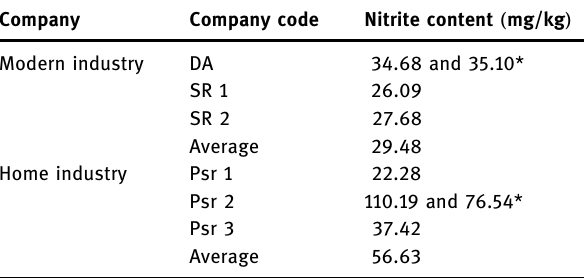
Table 1: Results of analysis of nitrite content in meat Company